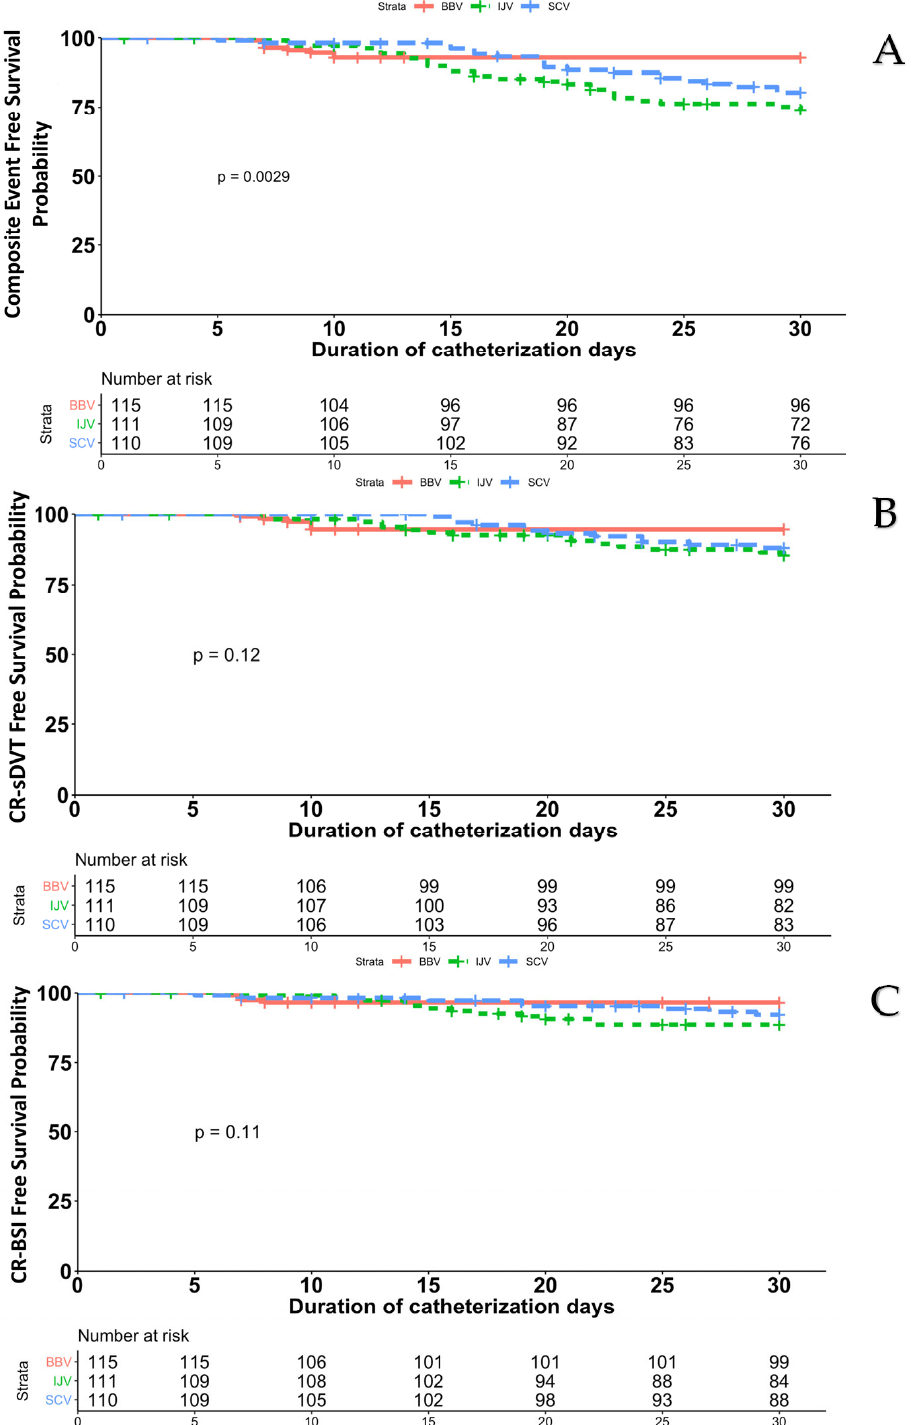
Figure 2. Rate of combined primary outcome events at 30 days after catheterization ( A ). Rate of catheter-related symptomatic deep-vein thrombosis (sDVT) at 30 days after catheterization ( B ). Rate of catheter-related bloodstream infection (BSI) at 30 days after catheterization ( C ). BBV, basilic/brachial vein; IJV, internal jugular vein; SCV, subclavian vein. Two patients from the BBV-cohort experienced both components of the composite endpoint (CR-sDVT and CR-BSI) almost simultaneously, but the event appearing first was considered as the primary outcome event (sDVT for both patients) for this analysis while they had been considered as separate for the evaluation of the single endpoint.